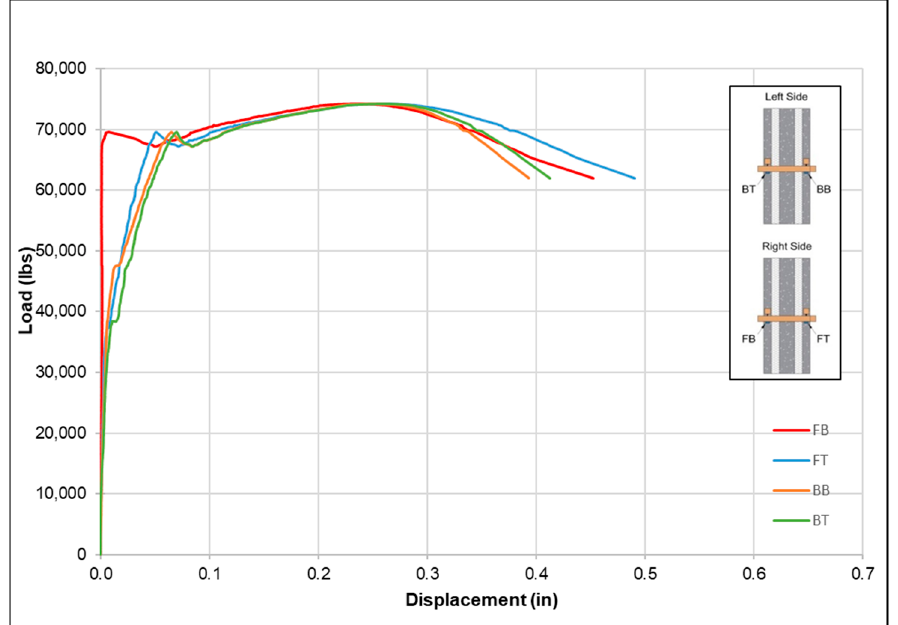
Figure 8. Load vs. displacement data from the four sensors for EPS.24.2.MMGRID.1.